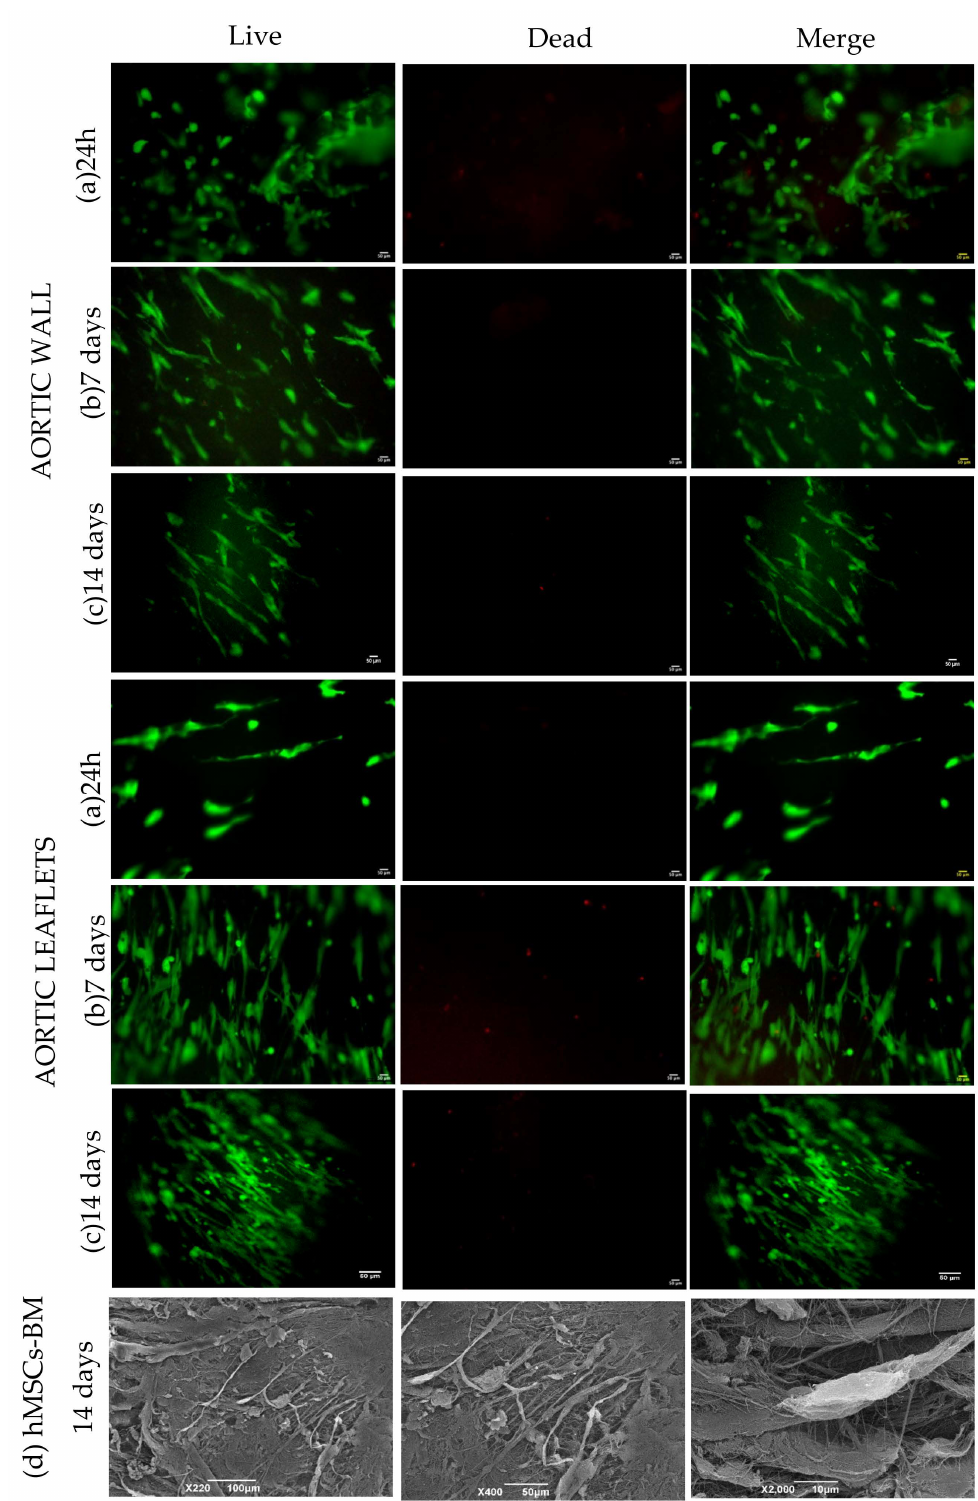
Figure 8. Live and dead staining analysis at ( a ) 24 h, ( b ) day 7 and ( c ) day 14 for aortic wall and leaflets samples. Images were taken with the Olympus IX7l microscope at 2 × magnification. ( d ) SEM images of the decellularized tissue cultured with hMSCs-BM (day 14) represented with red arrows. Pictures are shown in different scale of magnification (see the scale